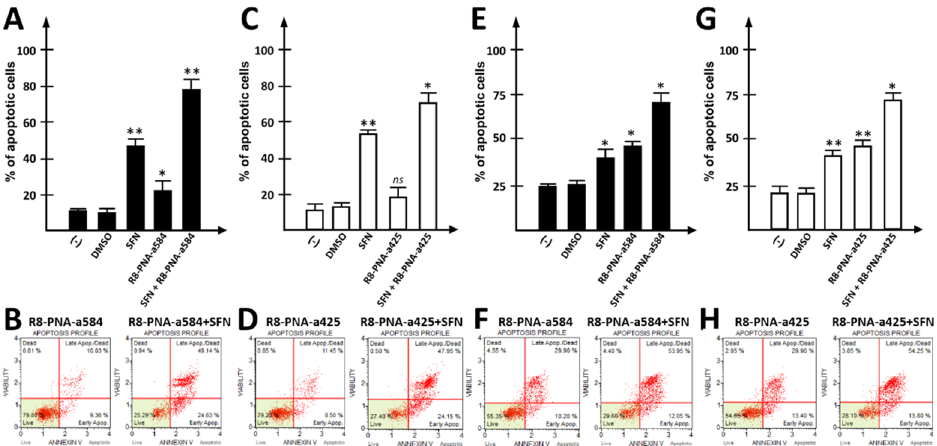
Figure 5. Effects of anti-miRNA PNAs combined with sulforaphane (SFN) on apoptosis induction. ( A , E ) Effects of anti-miRNA PNA against miR-584 (R8-PNA-a584) combined with active SFN on apoptosis induction in HT-29 ( A ) and LoVo ( E ) cells treated for 72 h. Apoptosis profile was determined using Annexin V assay. ( B , F ) Representative Annexin V assay plots. ( C , G ) Effects of anti-miRNA PNA against miR-425 (R8-PNA-a425) combined with active SFN concentration on apoptosis induction in HT-29 ( C ) and LoVo ( G ) cells. Apoptosis profile was determined using Annexin V assay. ( D , H ) Representative plots obtained by Annexin V assays. (* p < 0.05, ** p < 0.01, ns: not significant, n = 3 independent experiments).